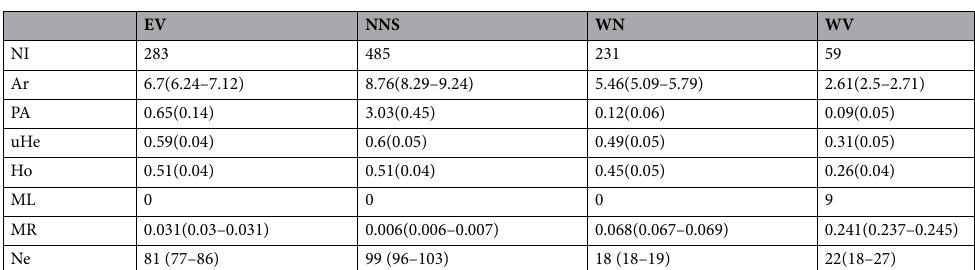
Table 2. Allelic patterns across four Structure-determined free-ranging dog populations showing lower genetic diversity in the WV population. NI number of individuals, Ar Allelic richness, PA number of private alleles, uHe Unbiased expected heterozygosity, Ho Observed heterozygosity, ML Number of monomorphic loci, MR Bootstrapped mean relatedness and Ne effective population size. Values in parentheses are standard errors, except for Ar and MR which is the 95% confidence interval about the mean calculated by 999 bootstrap replicates, and Ne is the parametric 95% confidence interval.